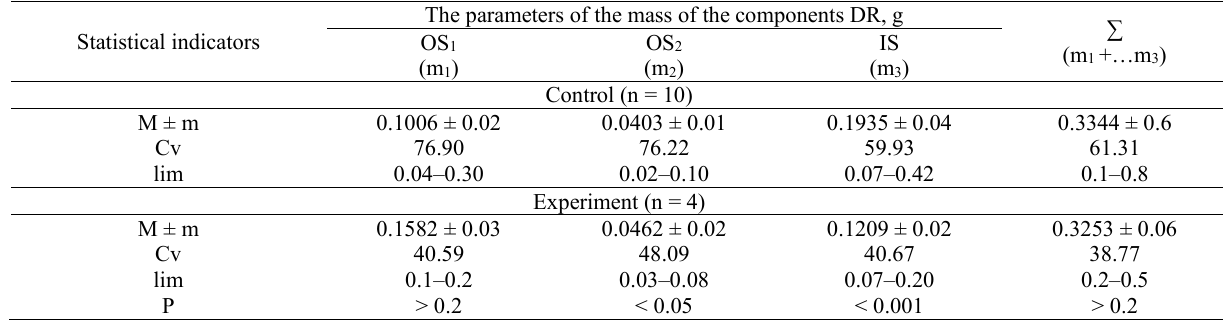
Table 3 Absolute indicators of samples of the dry residue of uterine and vaginal mucus The parameters of the mass of the components DR, g Statistical indicators